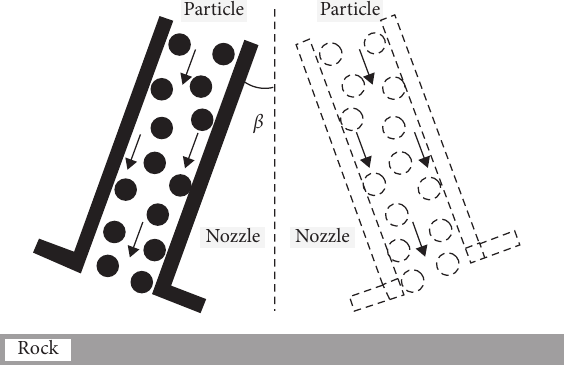
Figure 6: Particle jet impact rock with inclined Table 1: The mechanical properties of particle, water-jet, and rock.